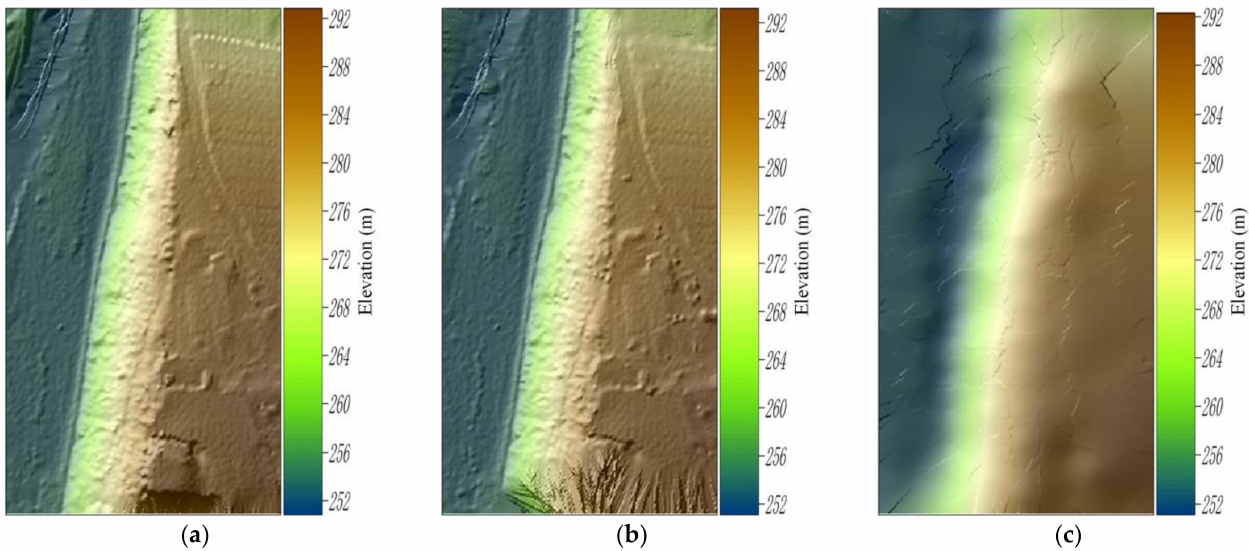
Figure 7. The initial provisional DEM surface with hillshade generated from seeds selected by different filters for samp51. ( a ) The reference DEM by ground points; ( b ) the initial provisional DEM by the proposed method; ( c ) the initial provisional DEM by the MHC method.